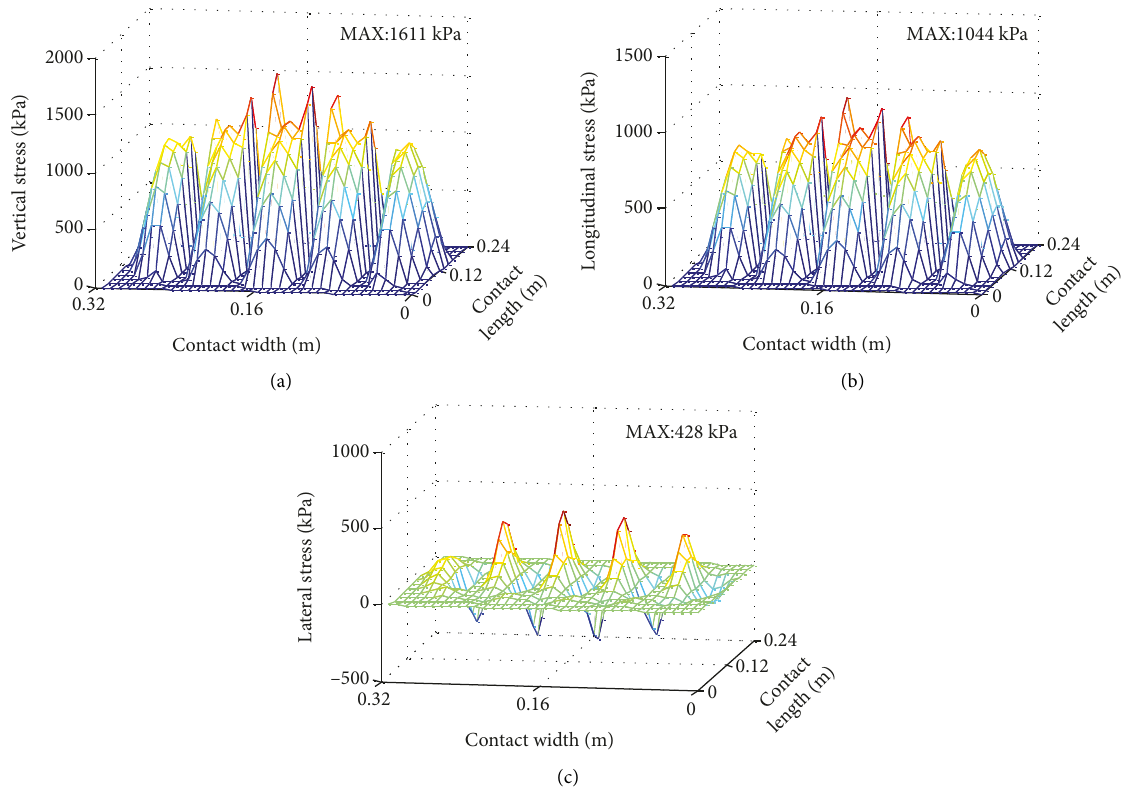
Figure 13: Contact stress under braking condition: (a) vertical stress, (b) longitudinal stress, and (c) lateral stress.